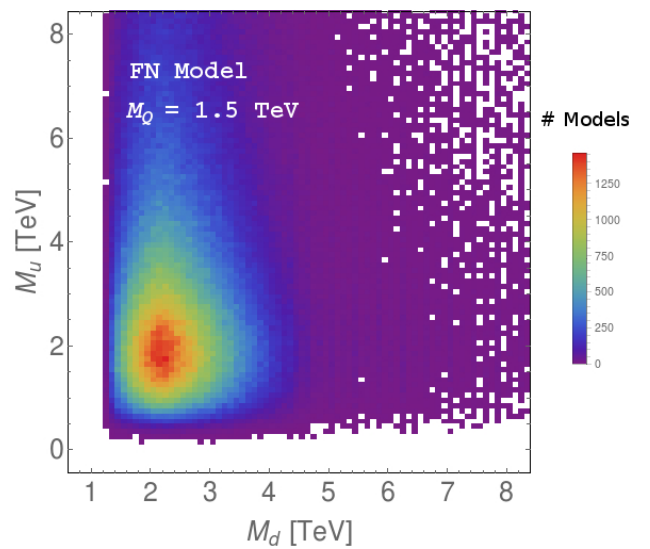
Figure 14 . Distribution of the combined lower bounds on the masses of the lightest gears of up and down type, M d ; M u ; due to low-energy observables for a million pairs of anarchic Yukawa matrices, holding M Q (cid:12)xed to 1.5